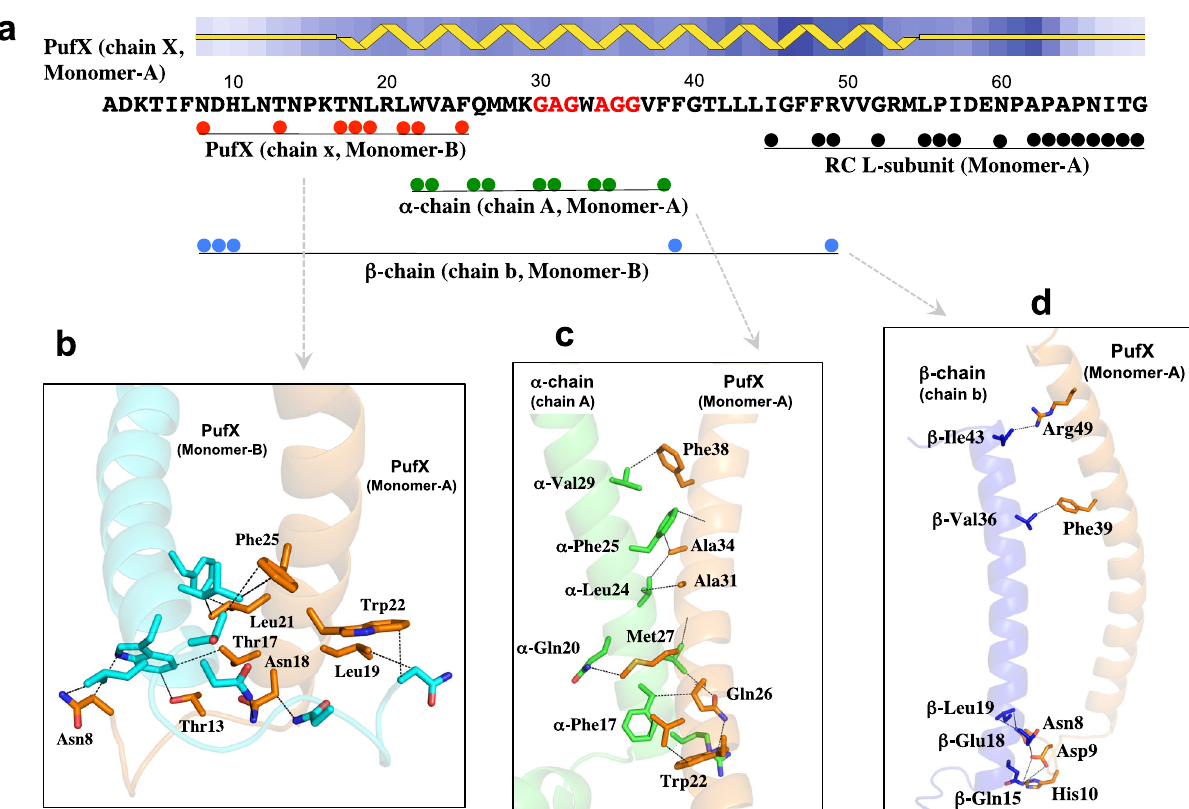
Fig. 4 Interaction mapping of PufX in monomer A with its partner proteins. a Primary sequence and secondary structure of the expressed PufX with the color spheres representing its amino acid residues that are in close contacts (<4.0 Å) with partner polypeptides as indicated. b Interactions between the two PufX polypeptides in their N-terminal regions with the dashed lines representing typical close contacts between the two polypeptides. c Close contacts (<4.0 Å) between PufX and an α -polypeptide of the same monomer in their transmembrane regions. The crossing portion in PufX corresponds to a short, Gly- and Ala-rich stretch as indicated by red fonts in the sequence of ( a ). d Close contacts between PufX and a β -polypeptide of a different monomer in their N-terminal and transmembrane